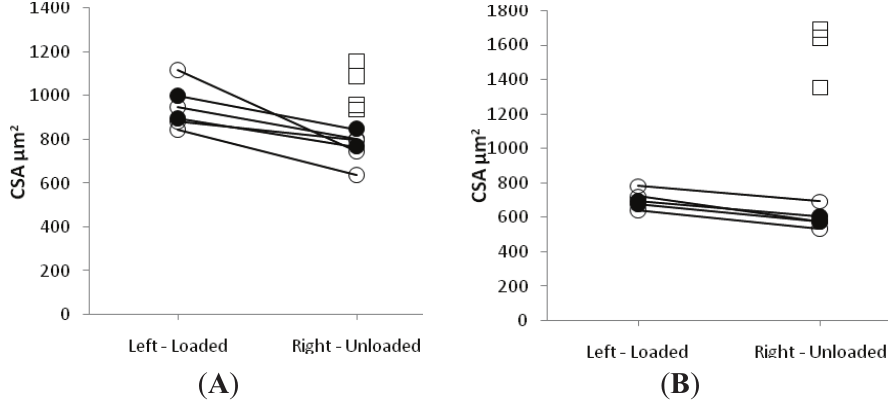
Figure 2. Average single muscle fiber area in the soleus (A) and the EDL (B) in the loaded and unloaded limbs in the control (squares), LC (open circles) and EC groups (filled circles).